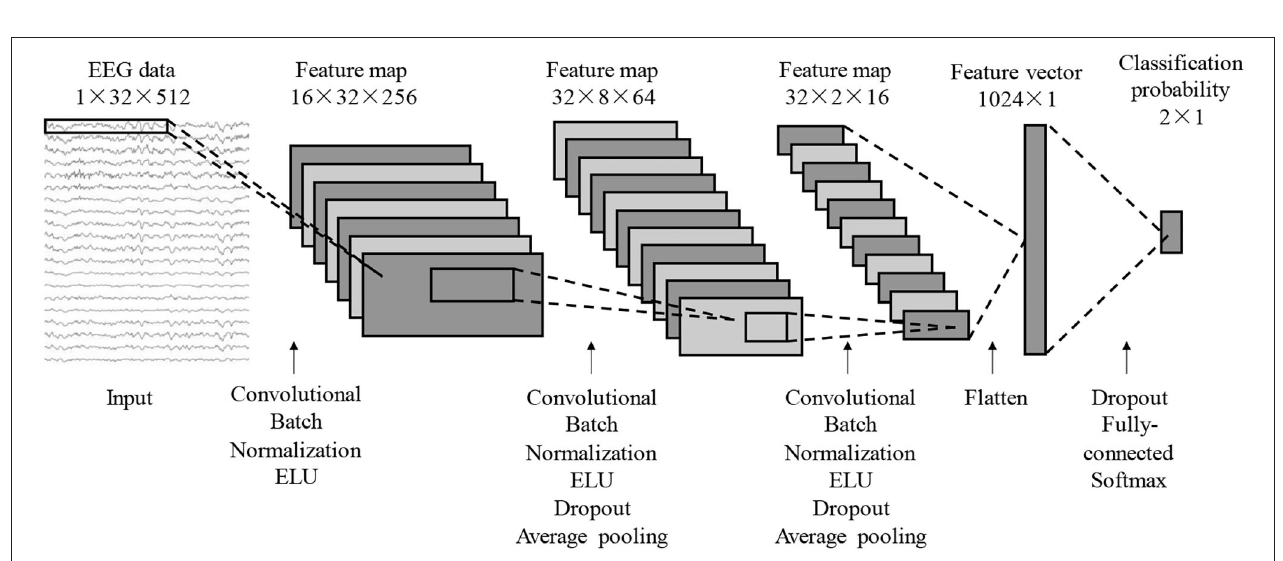
FIGURE 3 | CNN structure diagram that fuses spatial